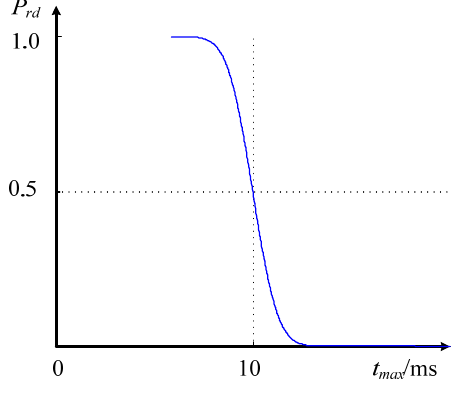
Figure 14. Refuse-operation probability with